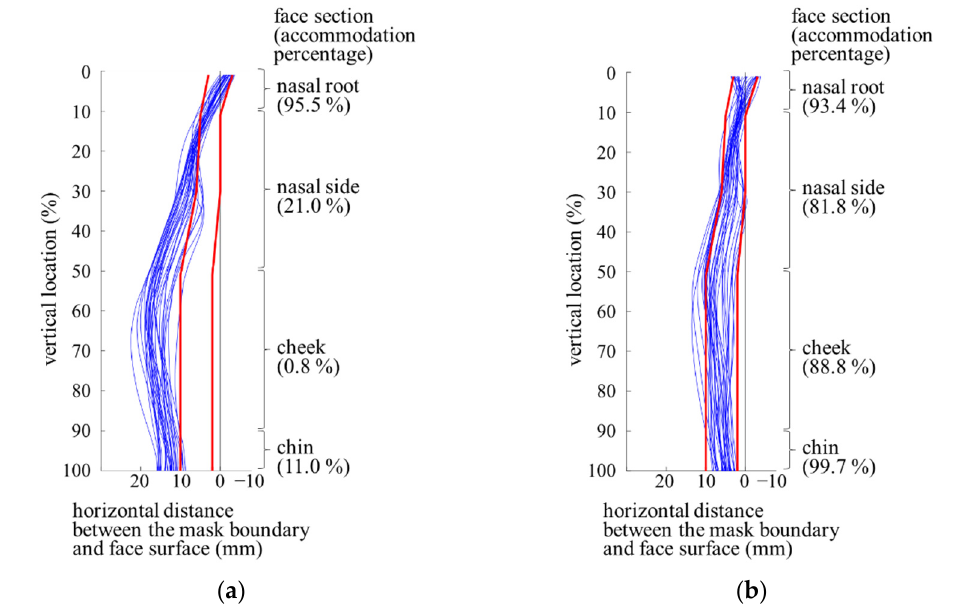
Figure 9. Virtual fit analysis results of the existing and alternative designs of pilot oxygen mask boundary (size: small narrow; red lines: the lower and upper limits of appropriate fit; blue lines: plots of the horizontal distances between the mask boundary and face surfaces). ( a ) Existing design; ( b ) alternative design.